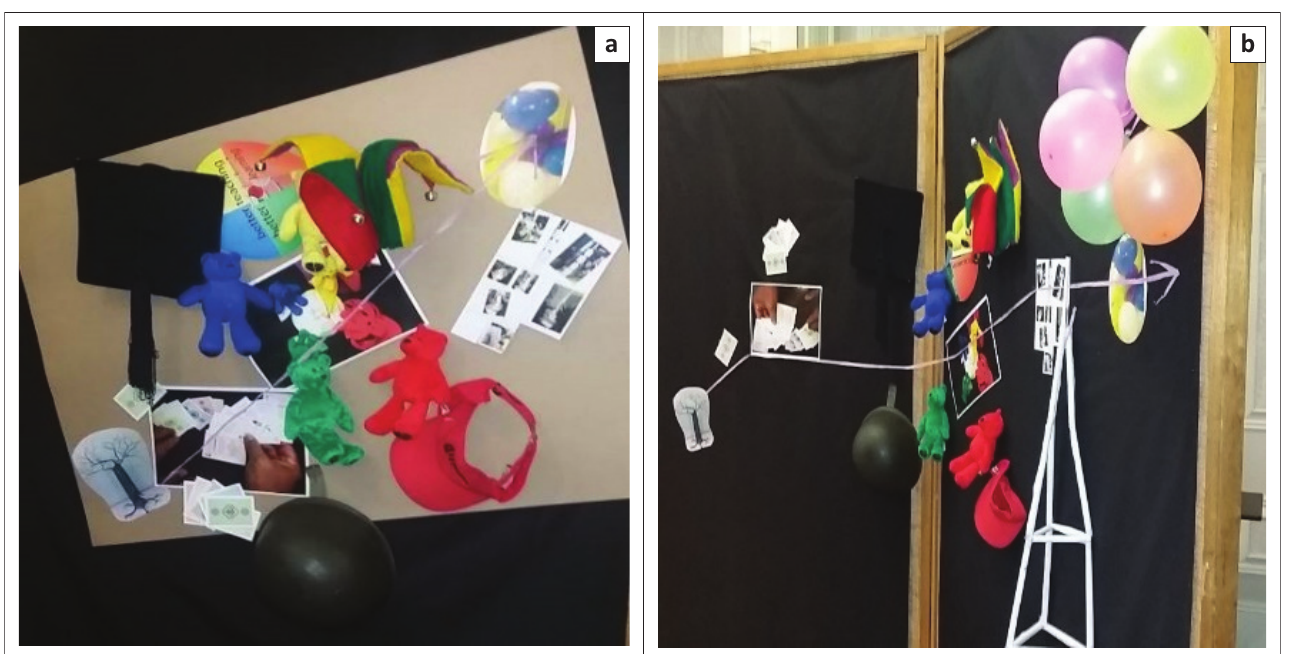
FIGURE 8: Exhibition.